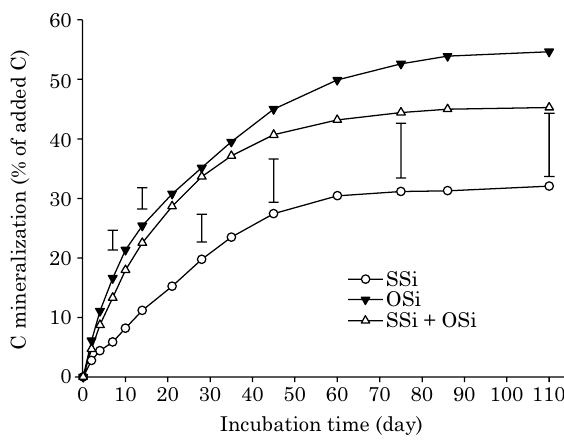
Figure 2. Cumulative C mineralization during the incubation of sewage sludge (SS) and oat straw (OS) incorporated (i) into soil (S) combined or alone. Vertical bars represent the minimum significant difference between treatment means (Tukey at 5